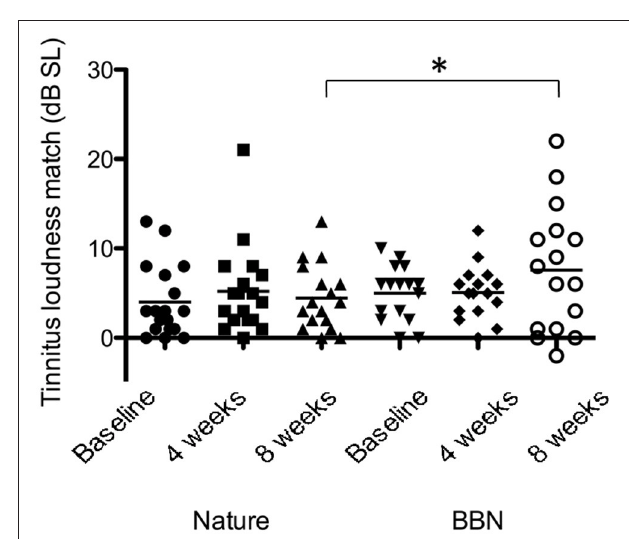
FIGURE 8 | Average LLMs (in dB SL) at baseline (filled circles for nature sounds; inverted triangles for BBN), at 4 weeks follow-up (squares for nature sounds; diamonds for BBN) and at 8 weeks follow-up (triangles for nature sounds; open circles for BBN) following administration of BBN (black) and nature (gray) sound stimuli. Horizontal lines represent average tinnitus loudness matches (in dB SL). Significant differences are indicated by * p < 0.05. Error bars represent ± one standard